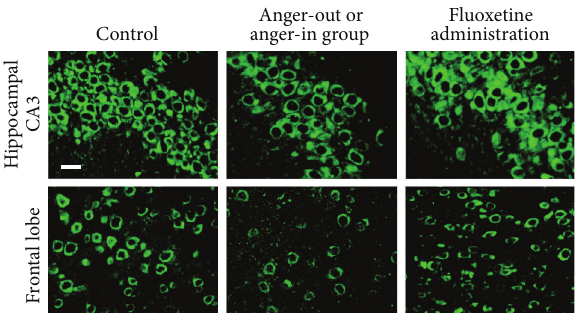
Figure 4: Hippocampal CA3 and frontal lobe (of control, anger- in/anger-out, and fluoxetine administration groups) were stained with anti-VEGFR2 antibody. Scale bar: 100 𝜇